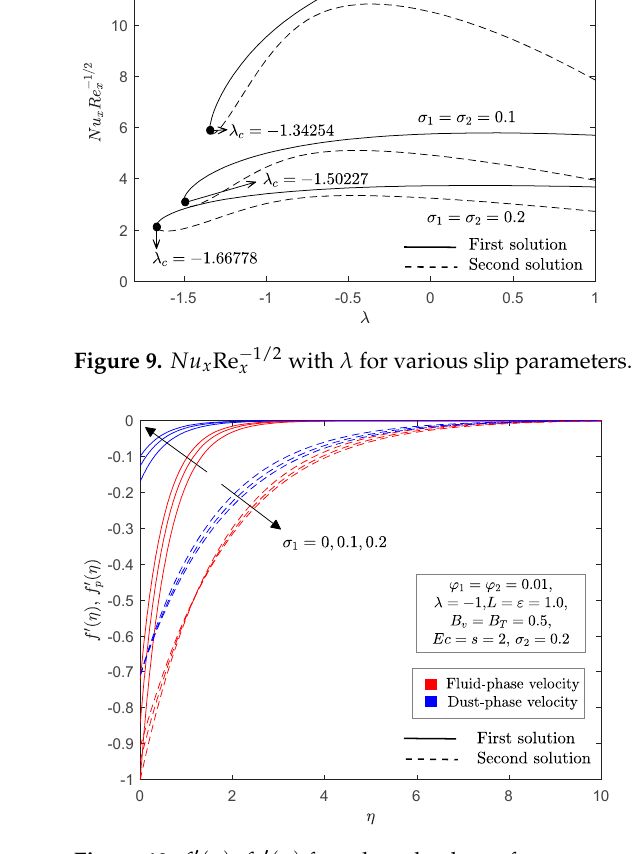
( ) ( ) , f f η η′′ for selected values of Figure 10. p Figure 10. f (cid:48) ( η ) , f p (cid:48) ( η ) for selected values of σ 1 . Figure 10. f η η′′ for selected values of